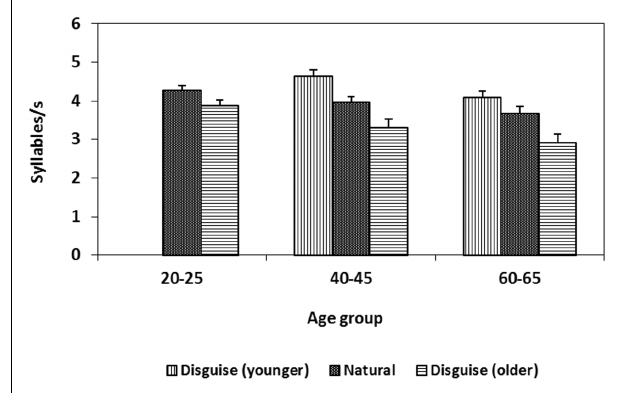
FIGURE 2 | Change in speech rate (syllables/s) when speakers from three age groups disguise their voice. Error bars indicate the standard error of the mean